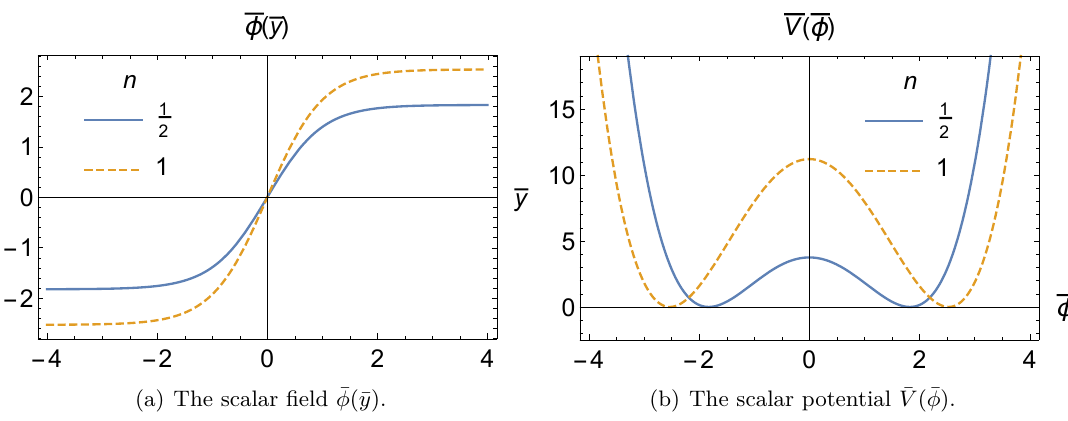
Figure 4 . Plots of the dimensionless scalar field ¯ φ (¯ y ) and the corresponding dimensionless scalar potential ¯ V (¯ φ ) in eq.